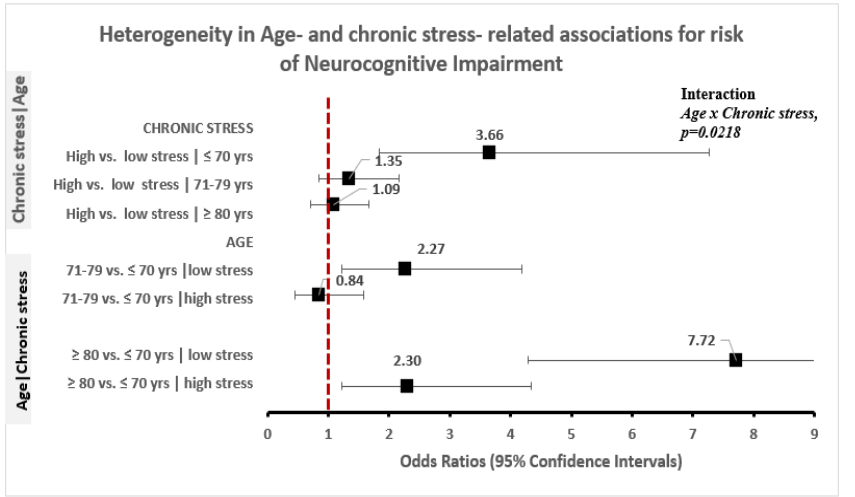
Figure 2. Heterogeneity in age and chronic stress-related associations for risk of neurocognitive impairment.